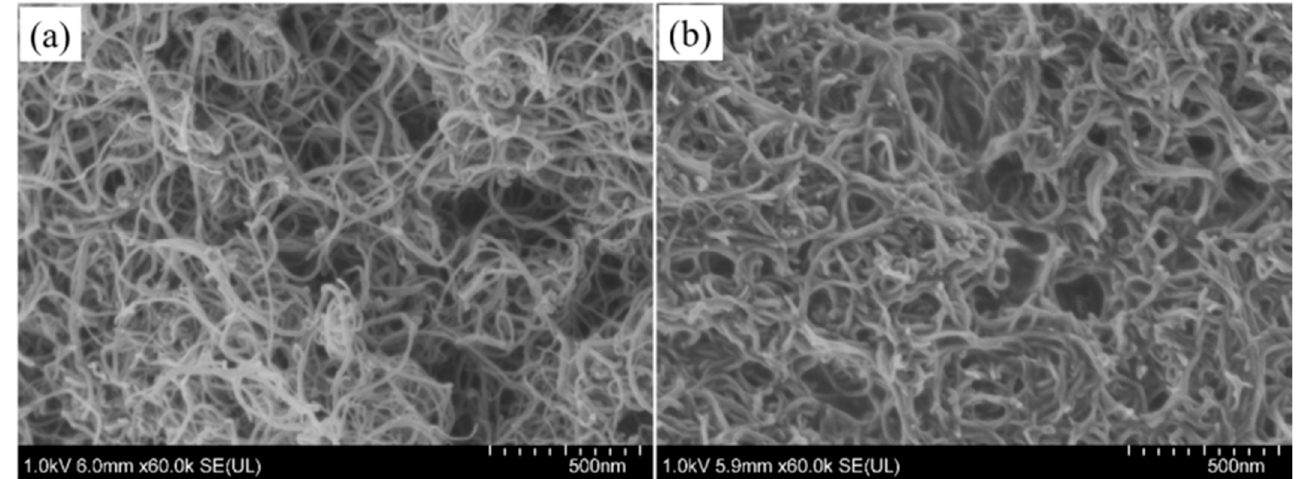
Figure 4. ( a ) SEM images of CNTs and ( b ) SEM images of CNTs-KH570-PGMA.